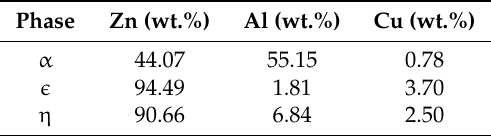
Table 2. EDS analysis of available phases in as-cast sample.